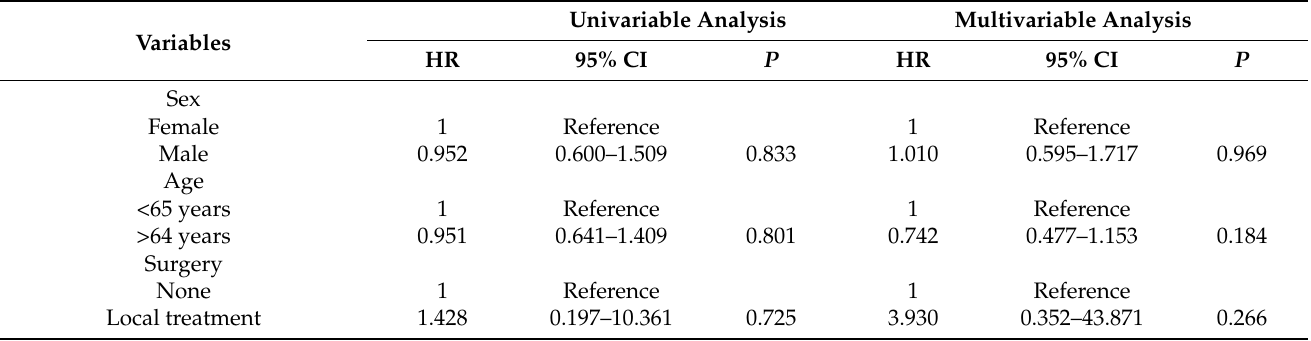
Table 4. Univariable and multivariable Cox proportional hazard regression analyses for mortality in 137 patients with ADSC.